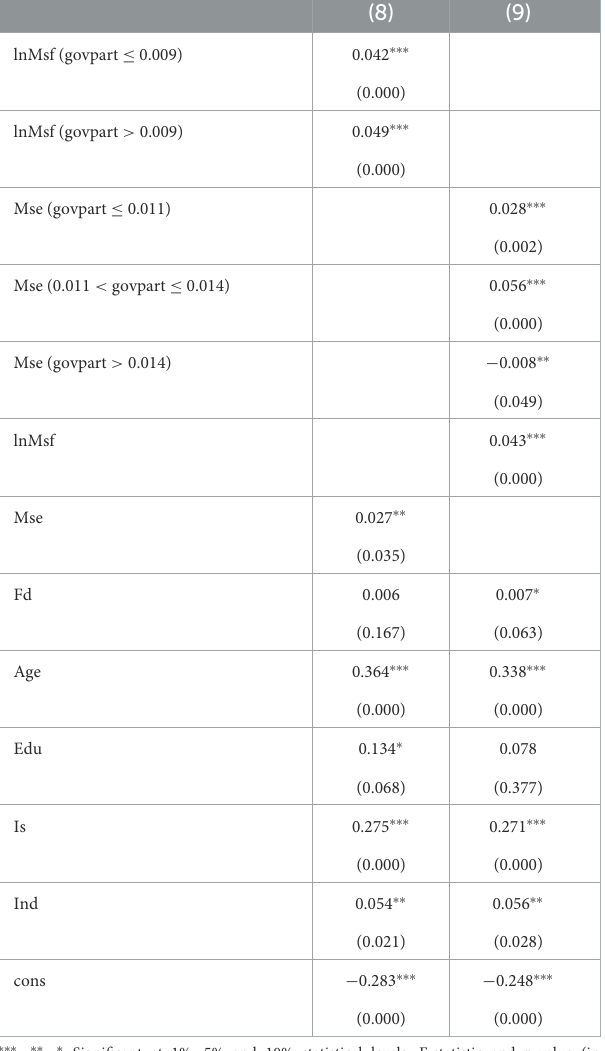
TABLE 5 Threshold regression